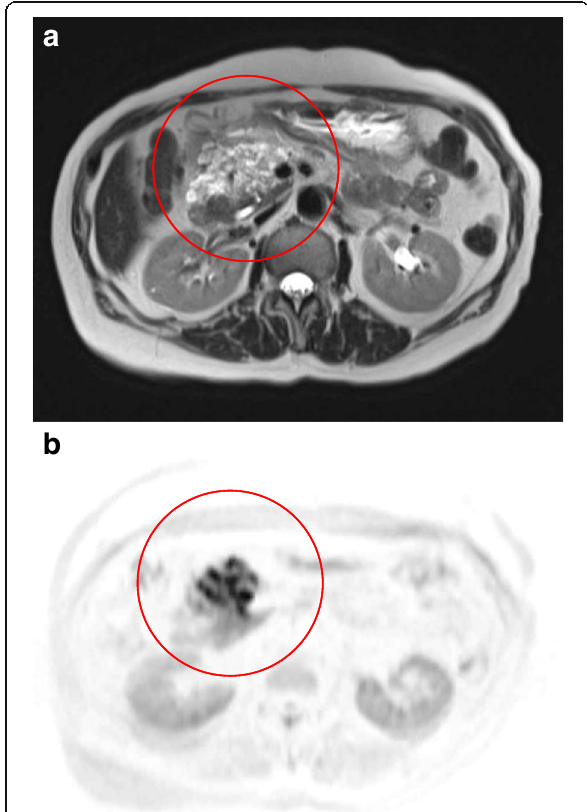
Fig. 2 MRI showed a lobulated tumor with mixed high and low signals on T2-weighted imaging ( a ). Diffusion-weighted images revealed a high signal lobulated tumor ( b ). (red circle in each image)